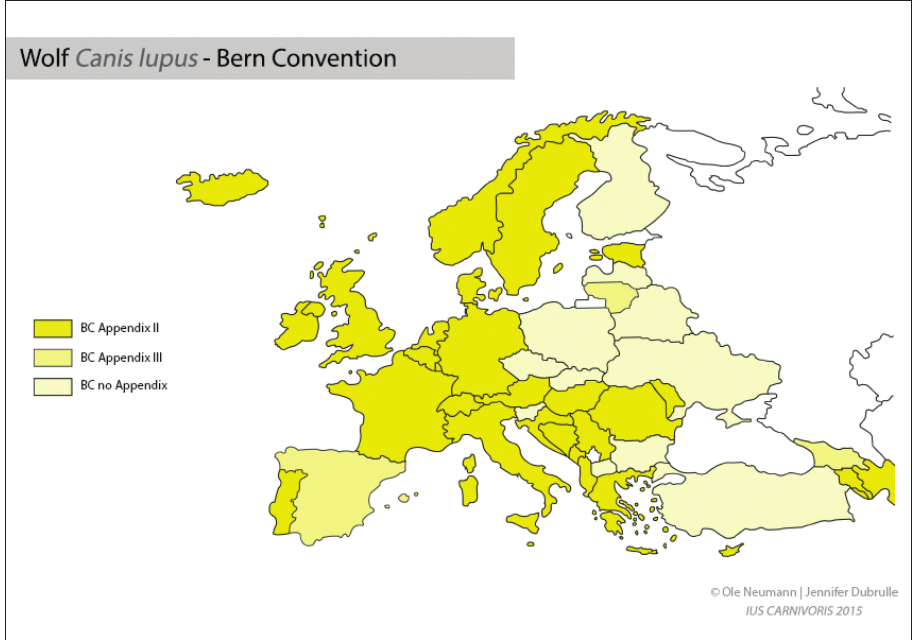
Figure 1. The legal status of wolves under the Bern